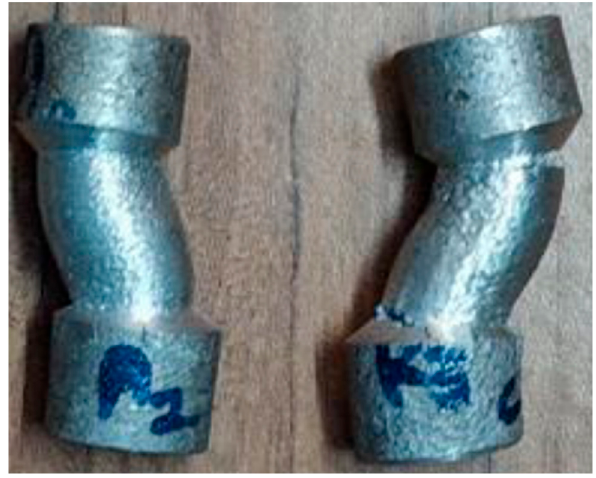
Figure 6. Compression strength specimen image.